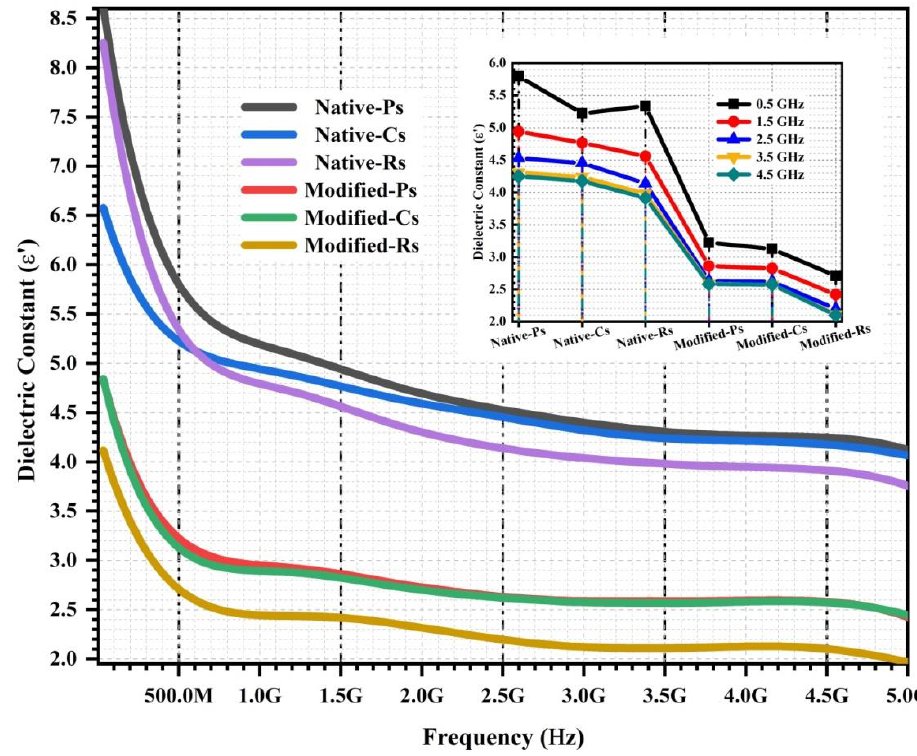
Figure 4. The variation in ε’ of native and modified of starches over the frequency.